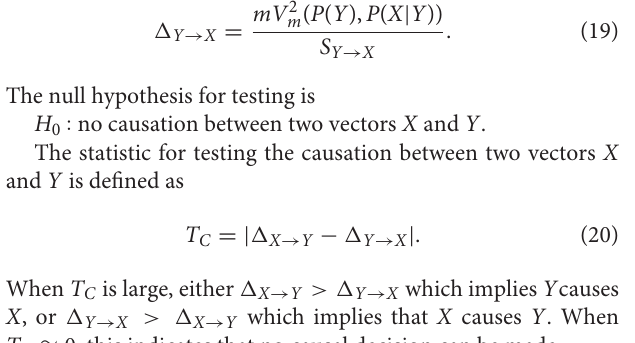
(15,15). Simulation scenario 3, (|X|,|Y|) =